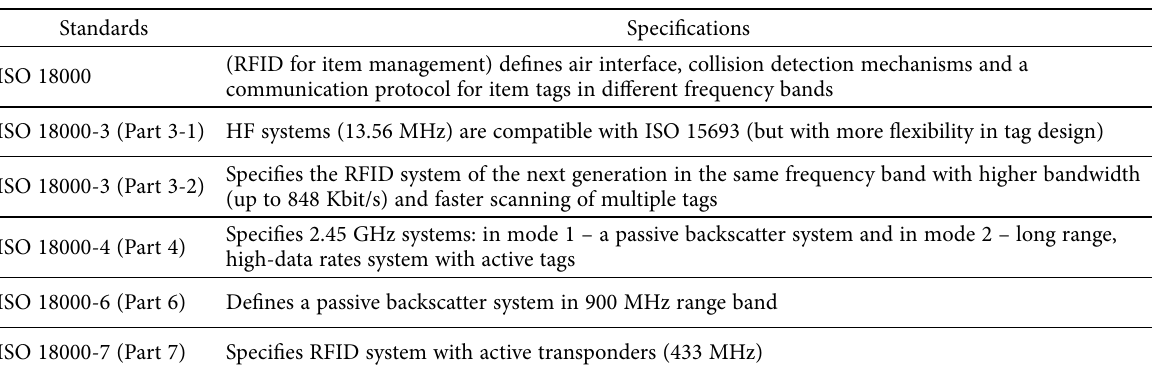
Table 1. A summary of RFID